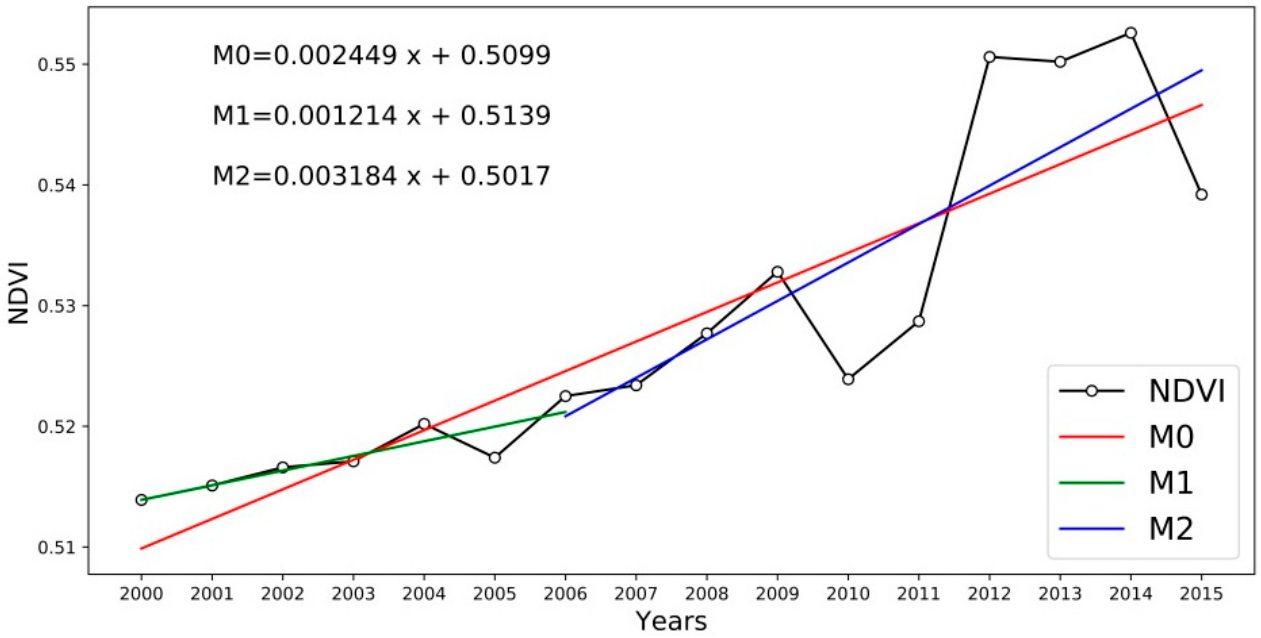
Figure 3. Interannual variation in NDVI in the YanHe Watershed from 2000–2015. The MK trend of NDVI represents the spatial distribution of vegetation change in the YanHe Watershed during 2000–2015 (Figure 4). After commencing the GFGP, vegetation followed a significant growth trend in most parts of the YanHe Watershed, with extremely significant and significant increases accounting for 78.08% and 11.87% of the total area, respectively. Areas with noticeable vegetation growth were distributed primarily in the upstream and downstream areas of the YanHe River. The upper reaches of the river are characterized by complex topography, with steep slopes (>25 ◦ ) accounting for more than 70% of the area [66], which has the most severe soil erosion in the whole basin and is a key area for the implementation of the GFGP. Thus, the vegetation cover in this area improved significantly. In the downstream area, agricultural activities were frequent; vegetation cover was poor at the start of the study; however, it was well restored after the implementation of the GFGP. In the middle reaches before the GFGP, the vegetation was relatively dense and had not changed significantly since 2000. The regions with significant vegetation degradation accounted for less than 1% of the total watershed area and were primarily distributed in the urban areas of Yan’an City. During urbanization, land use types are transformed from agricultural land and grassland to construction land, resulting in vegetation destruction and a declining NDVI trend. In general, after implementing the GFGP, the NDVI in the study area exhibited a steady increasing trend, indicating that the vegetation status of the YanHe Watershed, along with the ecological environment, had overall improved over